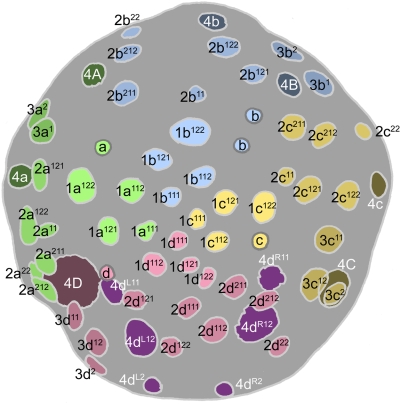
67-cell embryo, 760 min.Atypically, this embryo exhibits daughter nuclei of both 1b2 and 1d12.